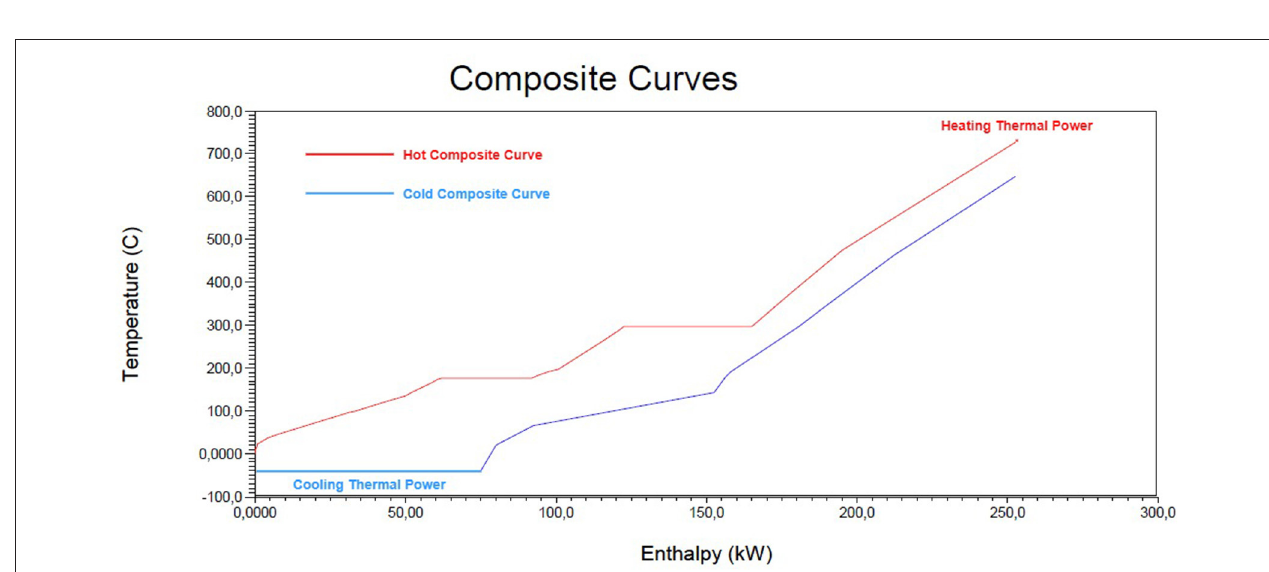
FIGURE 6 | The efficiency evolution of the overall system from Case I into Case III.